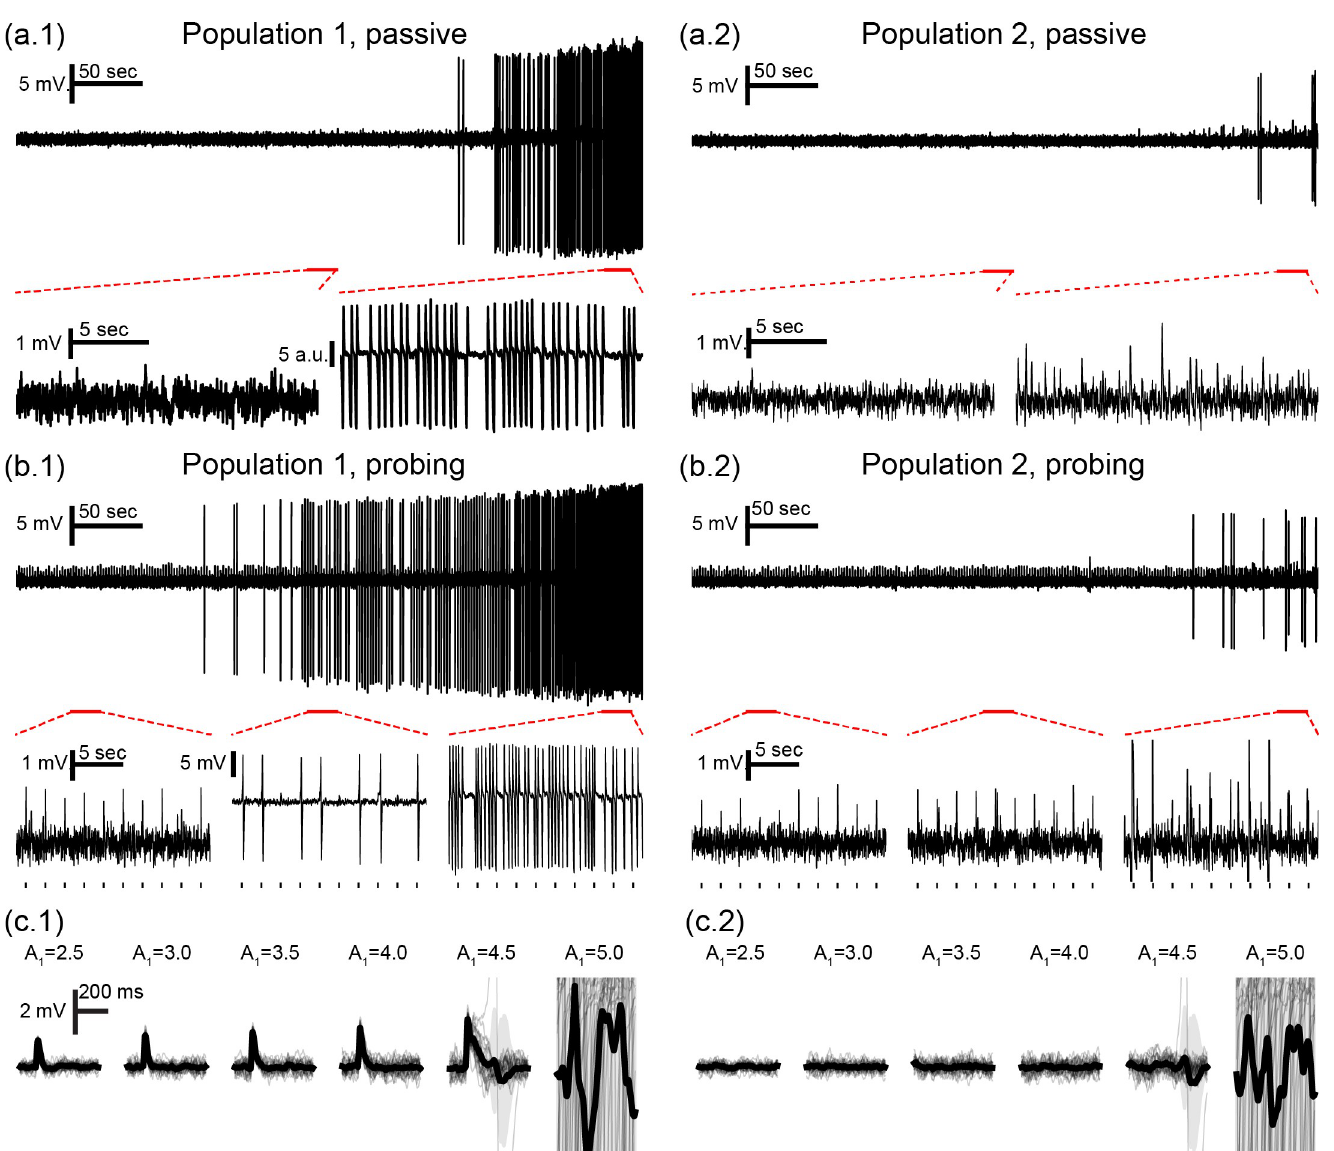
Fig 2. Neuronal mass model outputs with and without active probing stimuli. Simulation changing parameter A 1 from 4.30 to 4.95 (B = 40, G = 20) to elicit ictal activity in the end, with (a) passive observation or (b) active probing of both populations. Outputs are shown for population 1 (a.1 and b.1) and population 2 (a.2 and b.2), with tick marks showing stimuli onsets for (b). Ictal-like activity in the form of sustained discharges of spikes is observed for population 1 at the end of both simulations. ILS appear before this transition and are elicited even further in advance by stimulation. (c) Bottom plots show overlapped and mean response waveforms for increasing values of A 1 for (c.1) population 1 and (c.2) population 2. Gradual response changes are observed until the appearance of ILS for A 1 = 4.5 and ictal activity at A 1 =